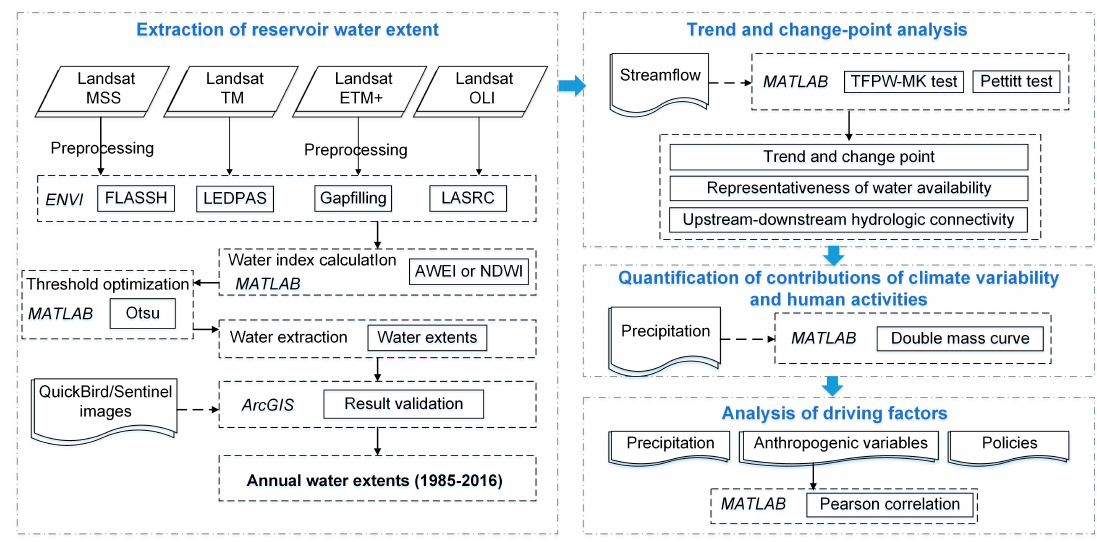
Figure 2. Workflow of this study.